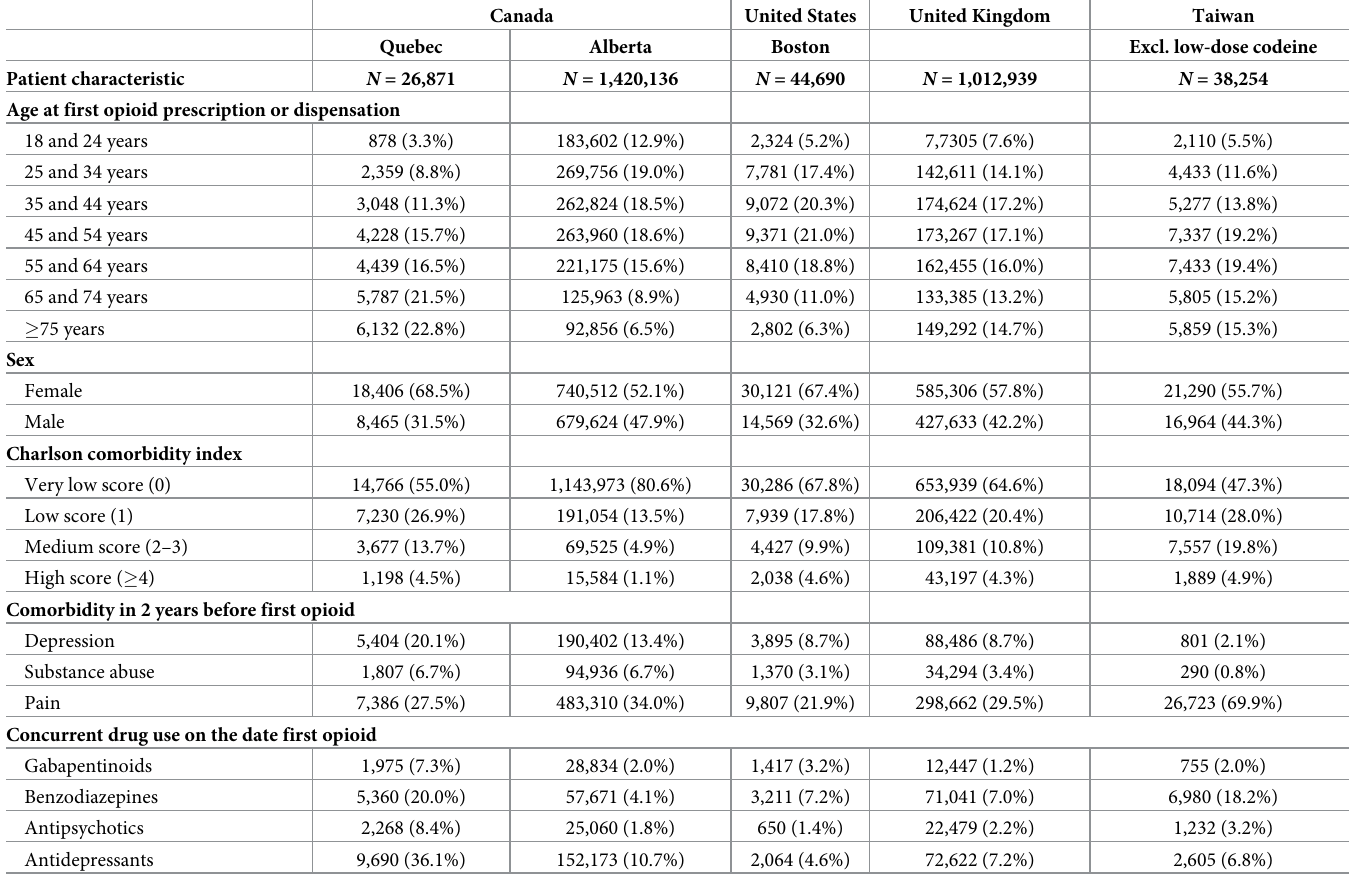
Table 1. The characteristics of people on opioids by